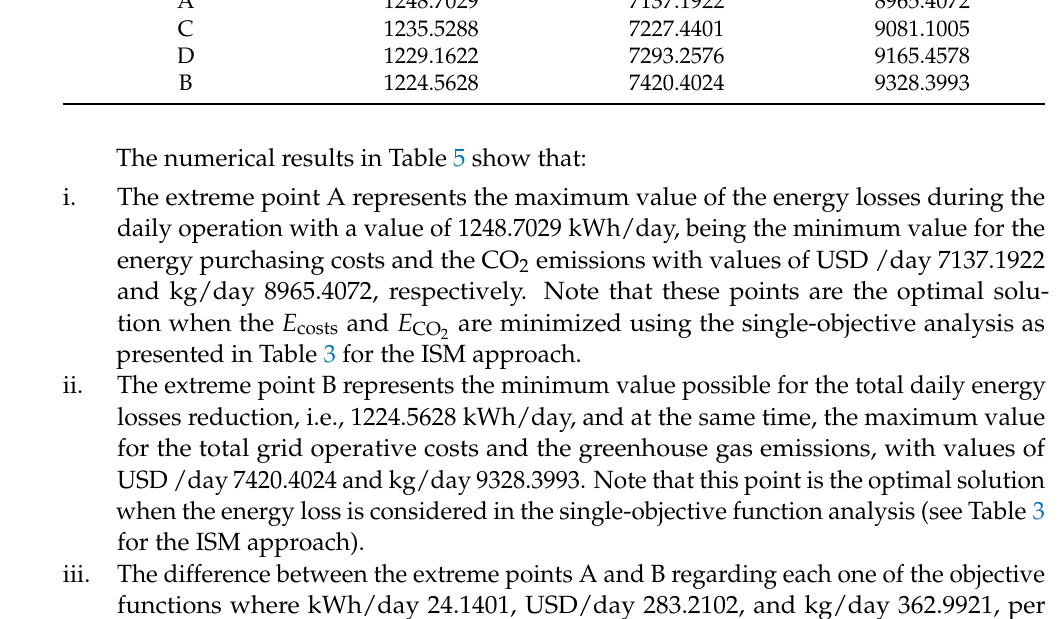
Figure 8. Pareto front for the conflicting objective functions: ( a ) E costs vs. E loss , and ( b ) E costs vs. E CO the extreme values (points A and B), and the central values in the case of points C and D. Table 5. Data of the market points for the Pareto front Figure 8a.